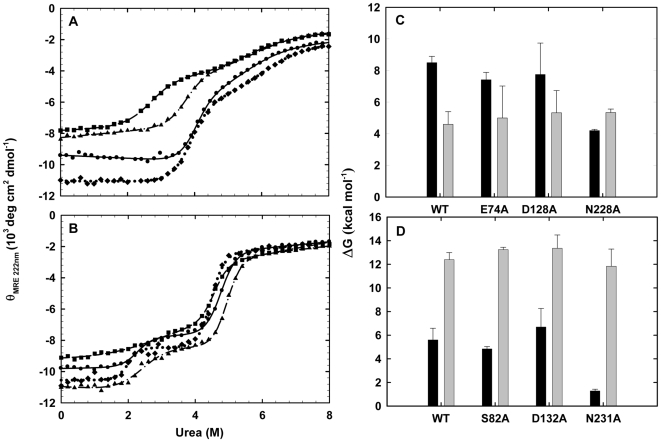
Stability perturbation of sIGPS and eIGPS by clamp deletion.(A) and (B) display urea denaturation equilibrium unfolding curves of WT and clamp-deletion variants of IGPS, the lines represent fits of the data for each variant to a 3-state equilibrium folding model as described in the text. (a) sIGPS: sIGPS-WT (•,–––––), sIGPS-Δβ2α2-E74A (▴,– • –), sIGPS-Δβ3α3-D128A (⧫,•••), and sIGPS-Δβ7α7-N228A (▪,– –). (b) eIGPS: eIGPS-WT (•,–––––), eIGPS-Δβ1α1-S82A (▴,– • –), eIGPS-Δβ3α3-D132A (⧫,•••), and eIGPS-Δβ7α7-N231A (▪,– –). (C) and (D) are bar graphs representing the free energy differences for the N to I step in unfolding, ΔG°NI, (black bars) and the I to U step, ΔG°IU (gray bars) for WT and the clamp-deletion variants of sIGPS (C) and eIGPS (D). The urea denaturation equilibrium unfolding curve of sIGPS-WT (A) and the corresponding folding free energy changes (C) are adapted from Forsyth et al.
[17].